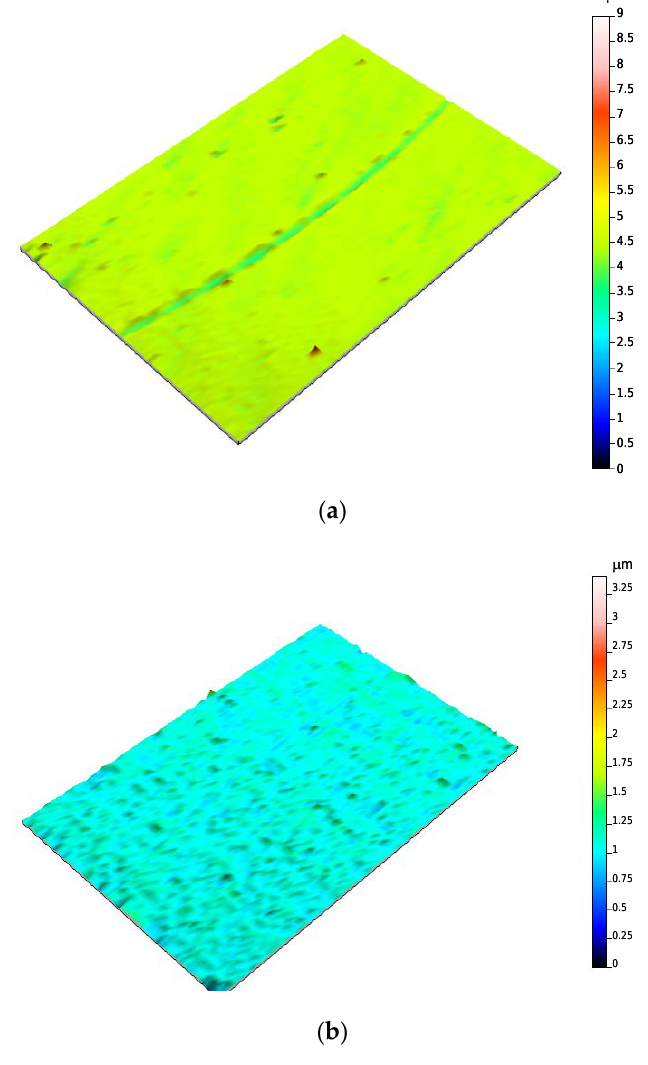
Figure 6. Surface topography profiles of AISI 316L disks after the tribological tests: ( a ) IL + G; ( b ) (IL + G) thin film.